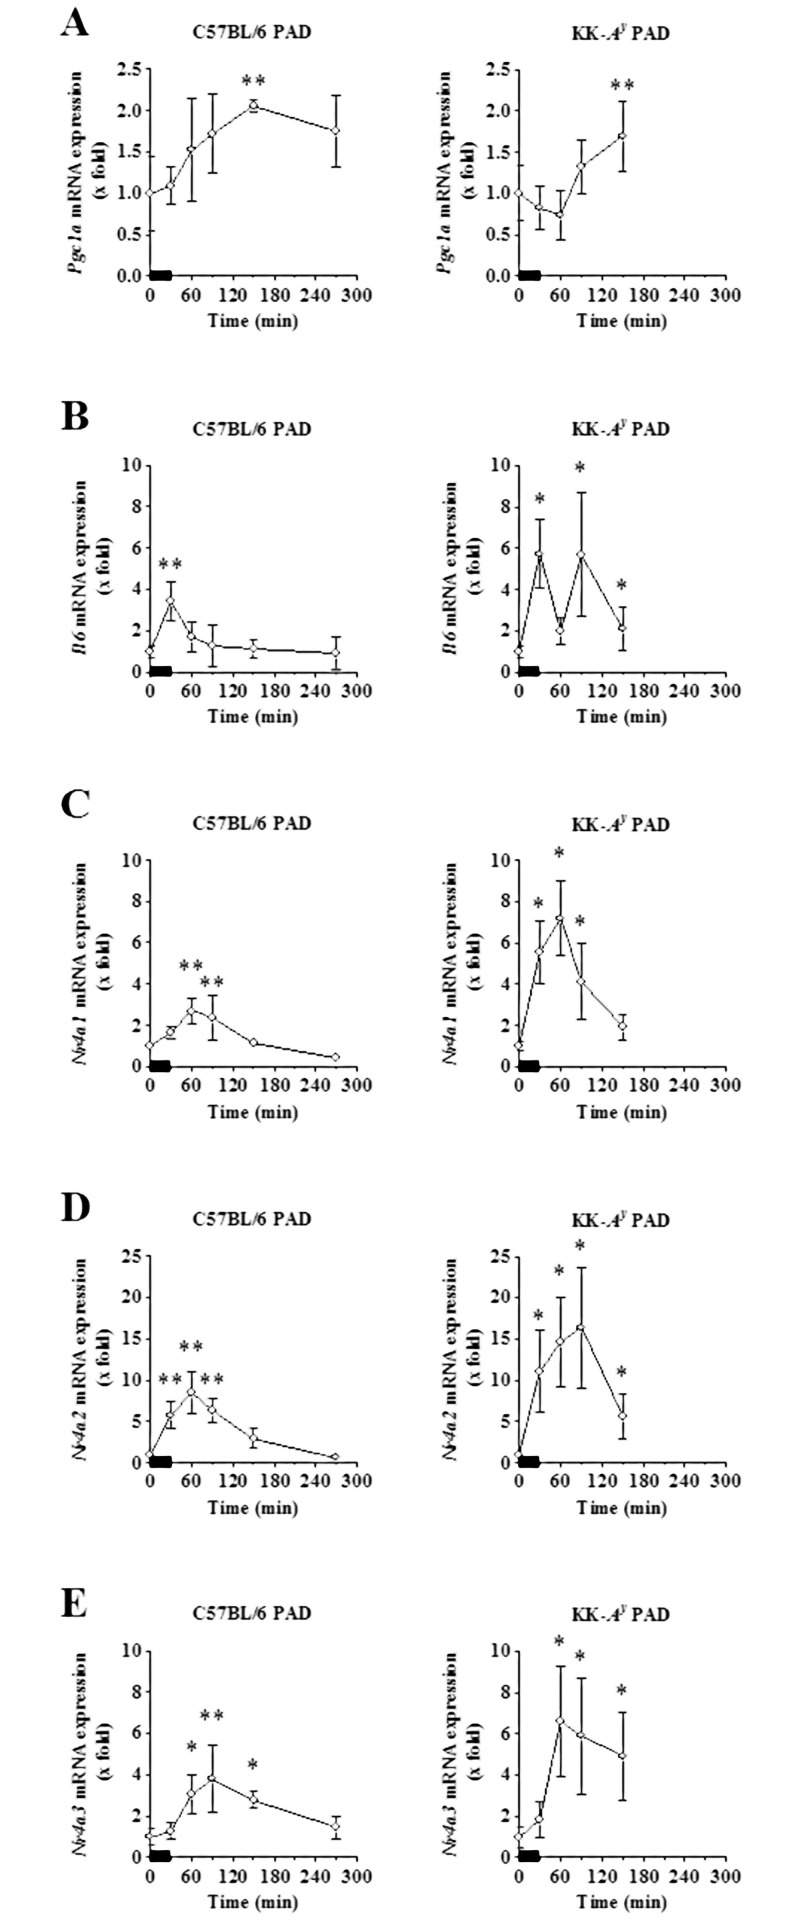
Acute effects of treadmill exercise on the mRNA expression of known exercise-responsive genes.The soleus muscles of exercised C57BL/6 PAD mice (n = 4 per time point, total 24, left panels) and KK-Ay PAD mice (n = 6 per time point, total 30, right panels) were obtained before and after the fifth treadmill exercise session. The mRNA expression levels of Pgc1a (A), Il6 (B), Nr4a1 (C), Nr4a2 (D), and Nr4a3 (E) in the soleus muscles were determined by qRT-PCR, normalized to Rplp0 expression level, and calculated relative to the pre-exercise group (0 min). The results are expressed as the mean ± SD. *p < 0.05, **p < 0.01 vs. 0 min (Dunnett’s test). Bold bars represent the timing of the fifth treadmill exercise.